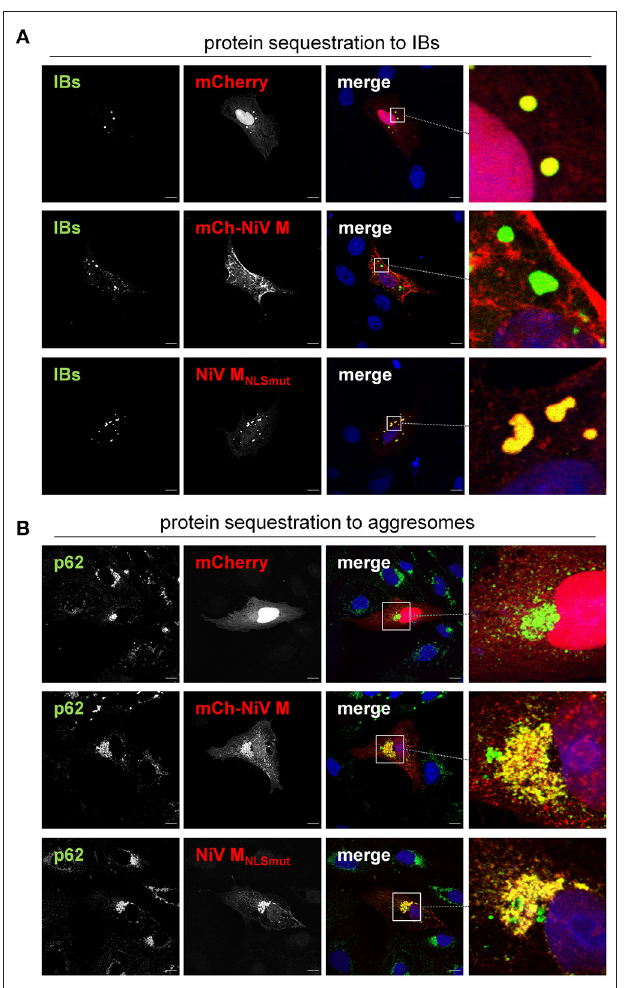
FIGURE 7 | Sequestration of overexpressed proteins to IBs and cellular aggresomes. (A) Vero76 cells were transfected with plasmids encoding NiV N and NiV PeGFP, together with either mCherry, mCherry-NiV M or NiV M NLSmut . 24h later, cells were fixed with 4% PFA for 15min and permeabilized with Triton X-100. IBs were detected by eGFP autofluorescence (green). mCherry or mCherry-tagged NiV M protein (mCh-NiV M) were detected by autofluorescence (red). NiV M NLSmut was detected using an M-specific antiserum (red). Nuclei were counterstained with DAPI (blue). (B) Vero76 cells were transfected with plasmids encoding mCherry or mCherry-NiV M or NiV M NLSmut . 4h p.t. cells were treated with 50nM bortezomib to induce aggresome formation. 24h after transfection, cells were fixed and permeabilized. Aggresomes were labeled with anti-p62 antibody (green). mCherry, mCh-NiV-M and NiV M NLSmut were detected as described above (red). Nuclei were counterstained with DAPI (blue). Boxed areas are shown at higher magnification on the right. Scale bars, 10 µ m.